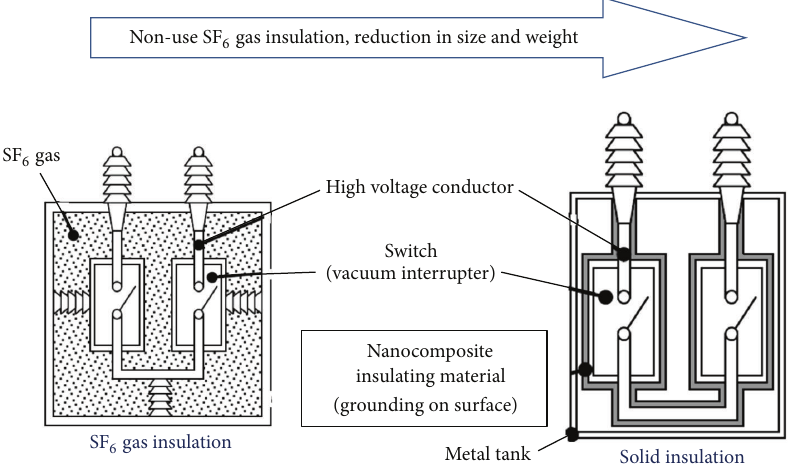
Figure 6: Example of nanocomposites in switchgear under development [25].